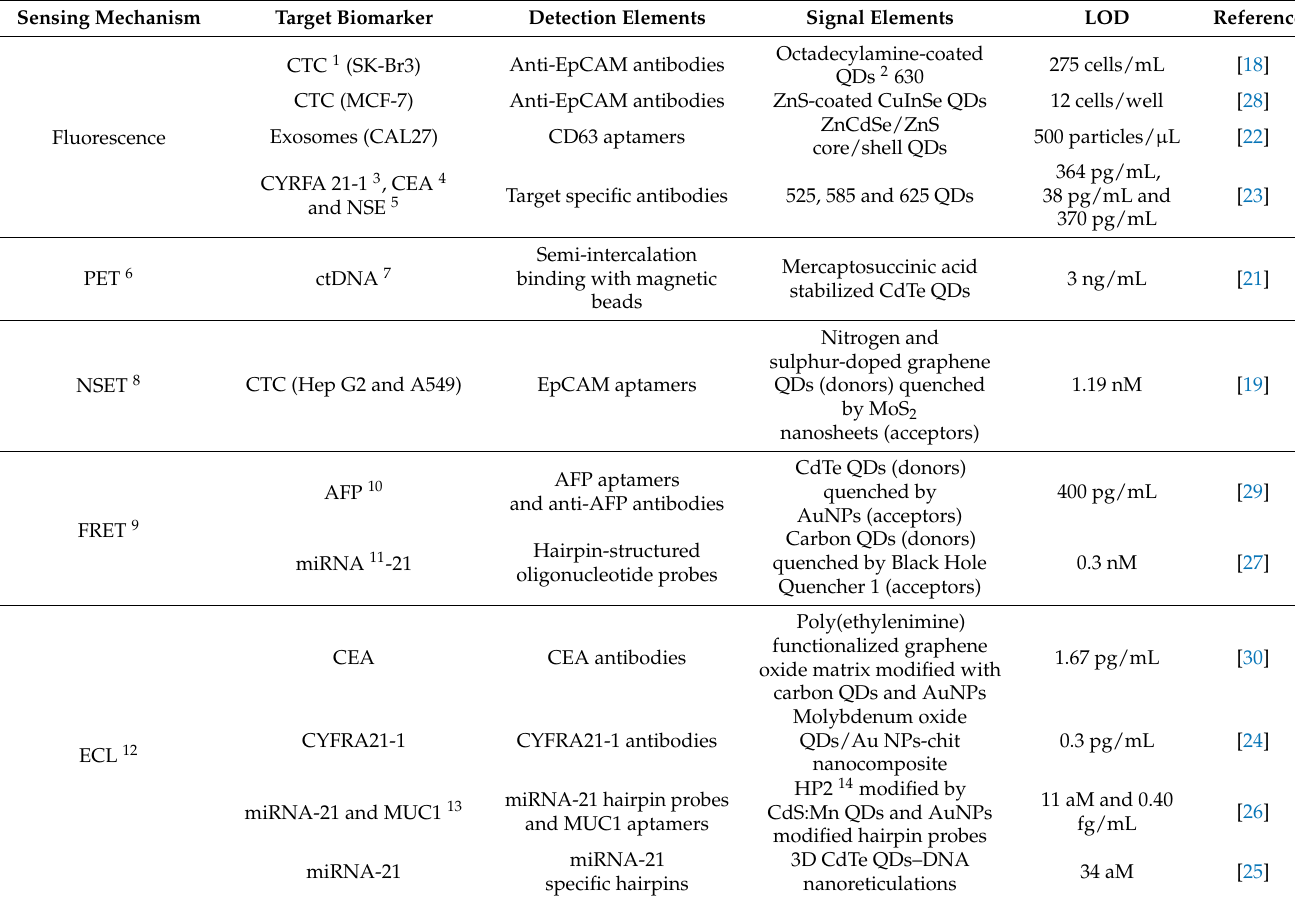
Table 1. Quantum dots-based optical biosensors for circulating cancer